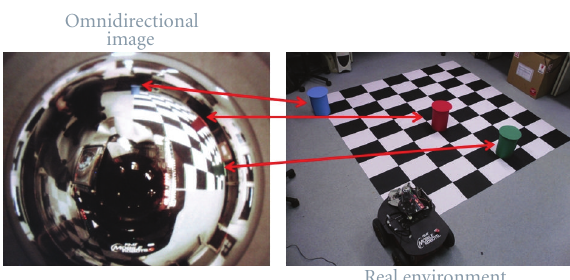
Figure 5: Correspondences among the omnidirectional image and the real environment.